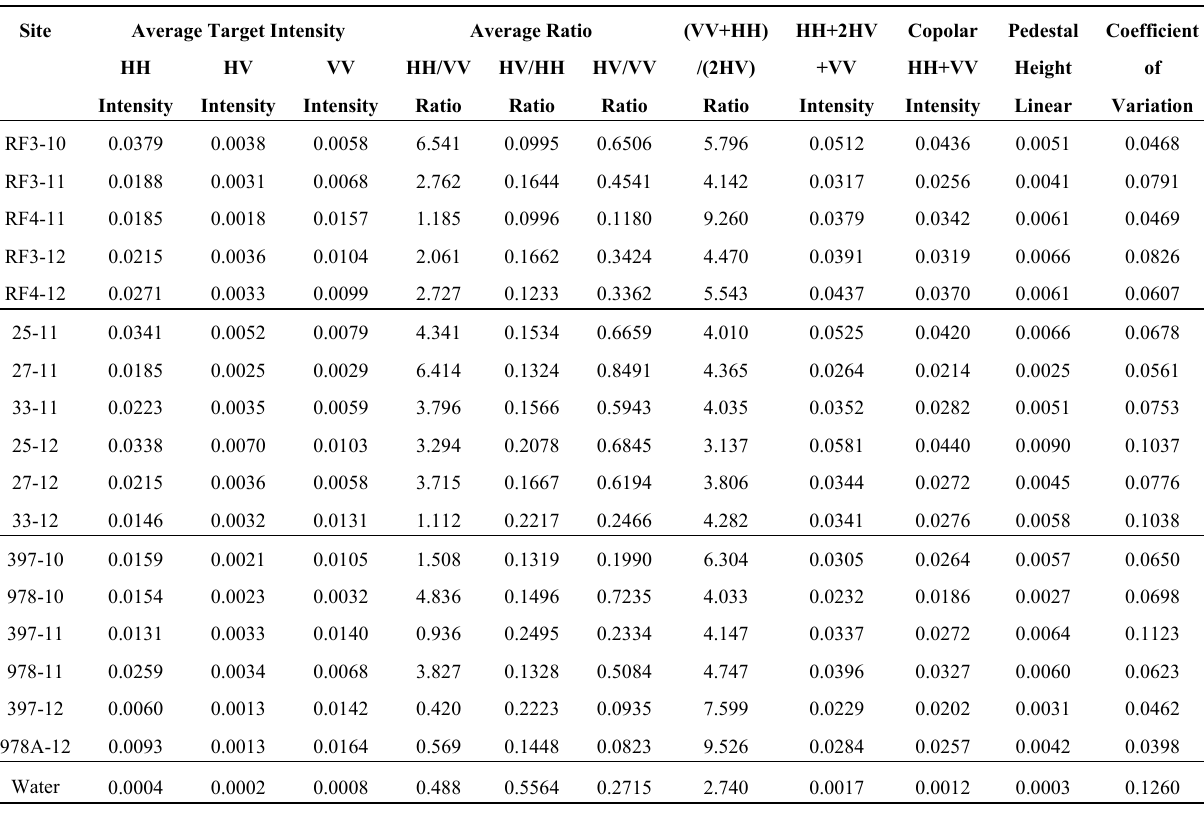
Table 2. PolSAR Biophysical Indicator Variables (Site labels as in Table